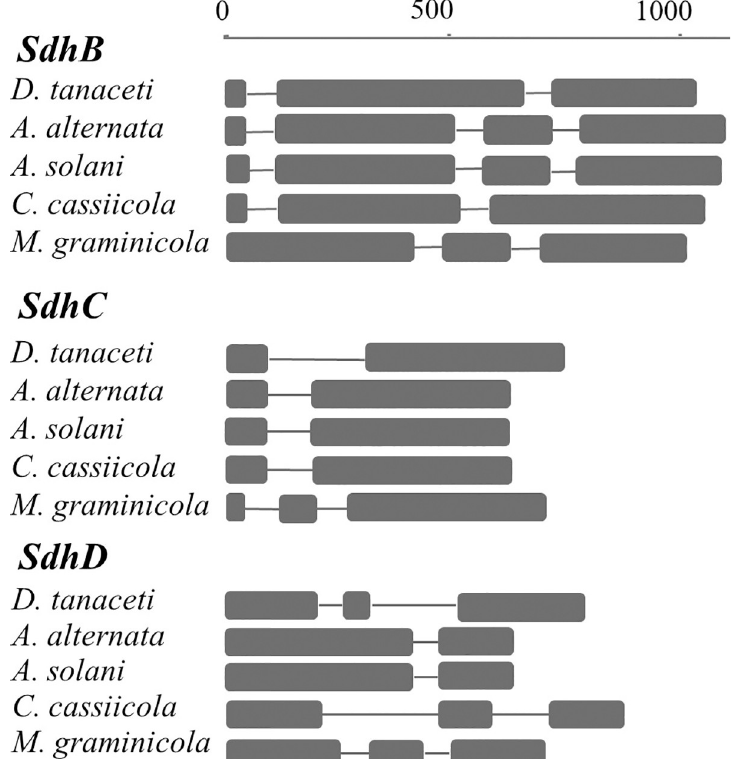
Fig 1. Structural arrangement of the succinate dehydrogenase subunit B, C and D genes of Didymella tanaceti , Alternaria alternata strain AR-SBL-4S [26], A . solani strain 1178-W1 [27], Corynespora cassiicola strain IbCor0008 [25], and Mycosphaerella graminicola strain R39-1 [16]. Squares indicate exons. Lines connecting the squares indicate introns. The scale bar indicates gene length (base